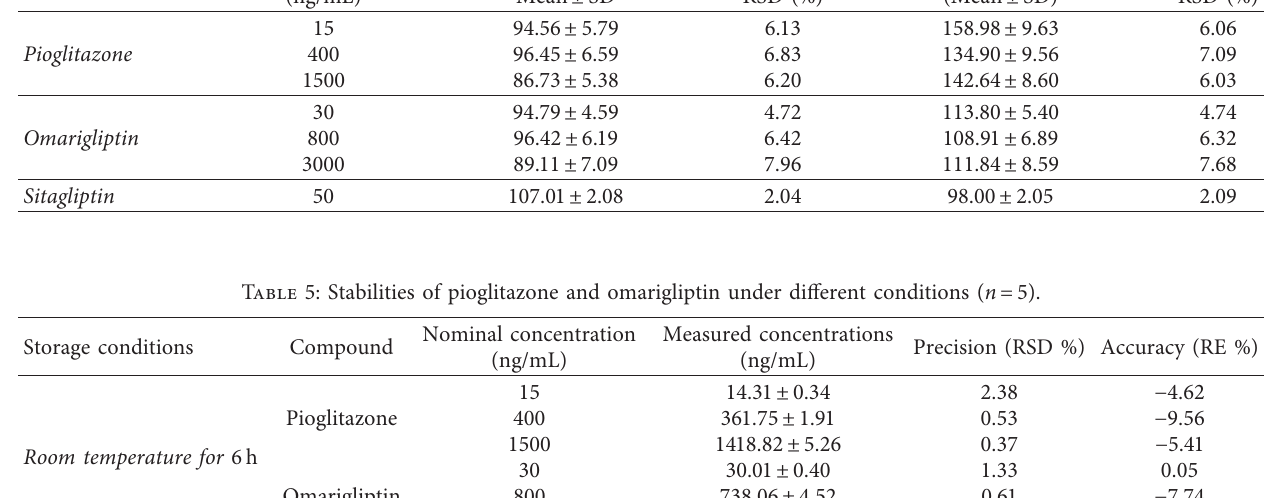
Table 4: Recovery and matrix effects of pioglitazone and omarigliptin in rat plasma ( n � 6). Analytes